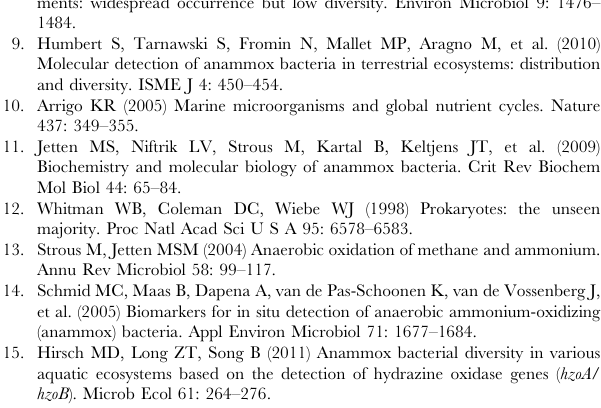
Figure S4 Maximum likelihood phylogenetic tree of nearly full-length anammox bacterial and environmen- tal 16S rRNA gene sequences. The tree branch distances represent nucleotide substitution rate and scale bar represents expected number of changes per homologous position. A . pyrophilus 16S rRNA gene sequence was used as outgroup. Bootstrap values (100 resamplings) are shown near the corresponding nodes. Sequences shown in red form a monophyletic cluster and putatively define the new anammox bacterium candidate species, Figure S5 Parsimony phylogenetic tree of nearly full- length anammox bacterial and environmental 16S rRNA gene sequences. The tree branch distances represent nucleotide substitution rate and scale bar represents expected number of changes per homologous position. A . pyrophilus 16S rRNA gene sequence was used as outgroup. Bootstrap values (100 resamplings) are shown near the corresponding nodes. Sequences shown in red form a monophyletic cluster and putatively define the new anammox bacterium candidate species, ‘‘ Ca . Scalindua pacifica’’. Figure S6 Ordination diagrams of Fast UniFrac PCoA analyses of the Bohai Sea sediment anammox bacterial assemblages. (a) The PCoA ordination diagram produced by using the Ca . Scalindua 16S rRNA gene sequences and (b) by using the anammox bacteria Hzo protein sequences. Shown are the plots of the first two principal coordinate axes (P1 and P2) of the weighted and normalized PCoA and the distribution of (a) the Ca . Scalindua 16S rRNA gene-typic assemblages and (b) the anammox bacterial Hzo protein-typic assemblages (designated with the sampling station names) in response to these axes.